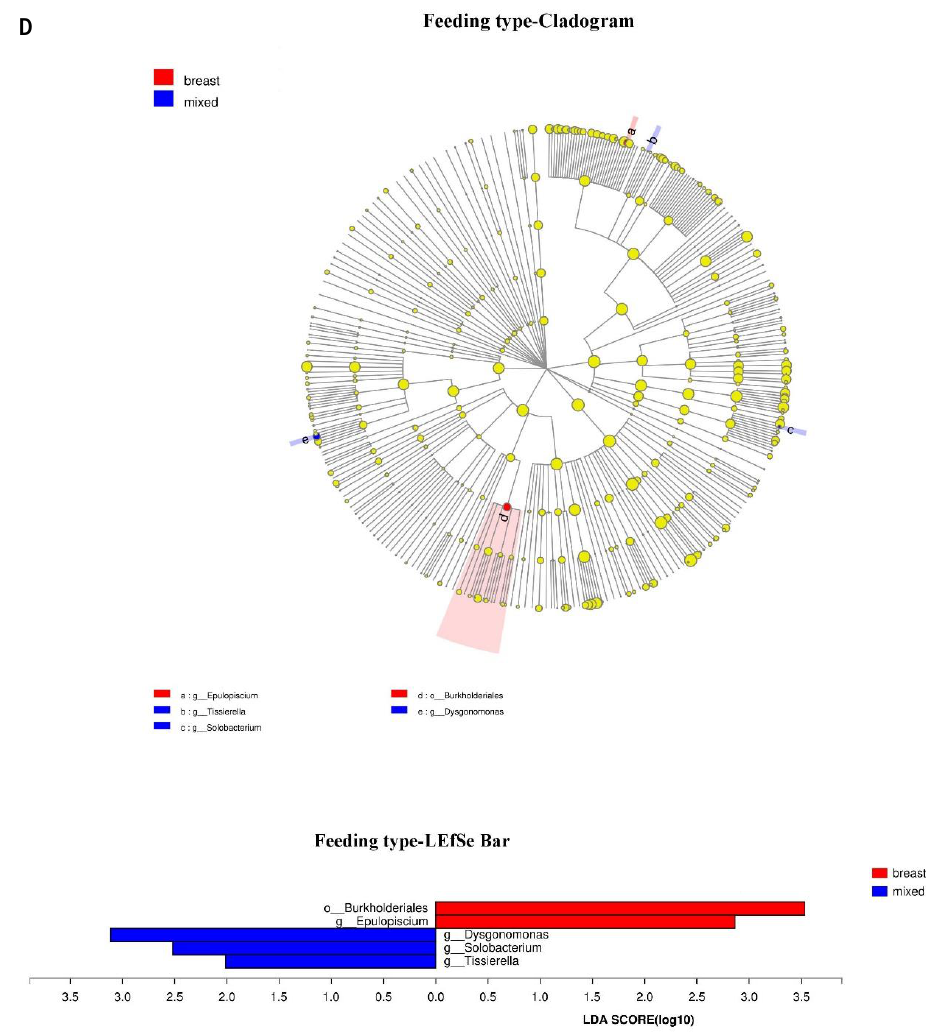
Figure 3. Taxonomic representation of statistically and biologically consistent differences between different groups (( A ) probiotic consumption; ( B ) antibiotic exposure; ( C ) delivery mode; ( D ) feeding type). Differences are represented by the color of the most abundant genus. The diameter of each circle is proportional to taxon abundance; from inside to outside circle indicate the phylum to genus level in turns (g: genus; f: family; o: order; c: class). Histogram of the linear discriminant analysis (LDA) scores for differentially abundant genera. The threshold on the logarithmic LDA score for discriminative features was set to 2.0; the larger the LDA score, the greater influence of species abundance on the difference between two groups. (( A ) Probiotic consumption: More abundant in no